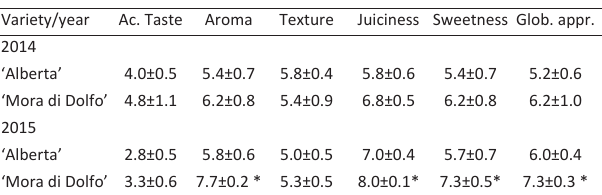
Scores were based on a nine-point hedonic scale: 1= extremely dislike; 5= neither like nor dislike; and 9= extremely likeWithin years asterisk indicates significant differences between varieties by Student t -test ( P